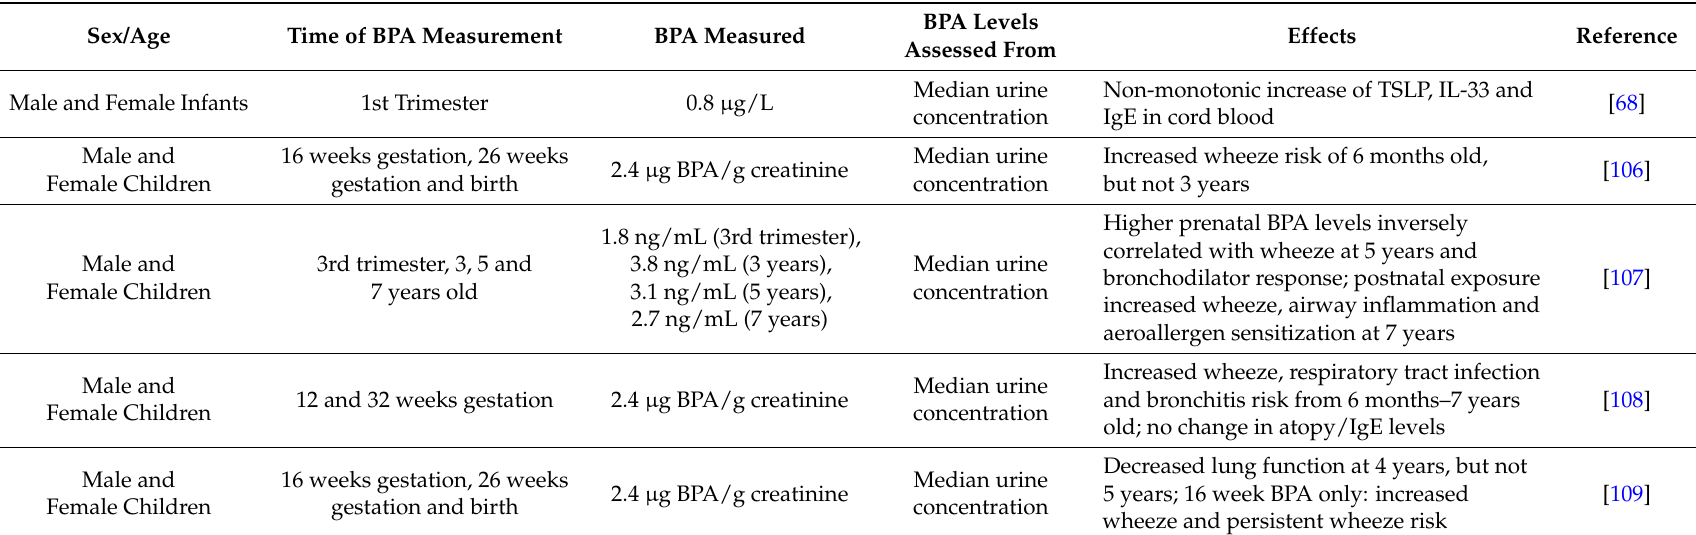
Table 4. Summary of allergy/asthma epidemiological studies from BPA exposed